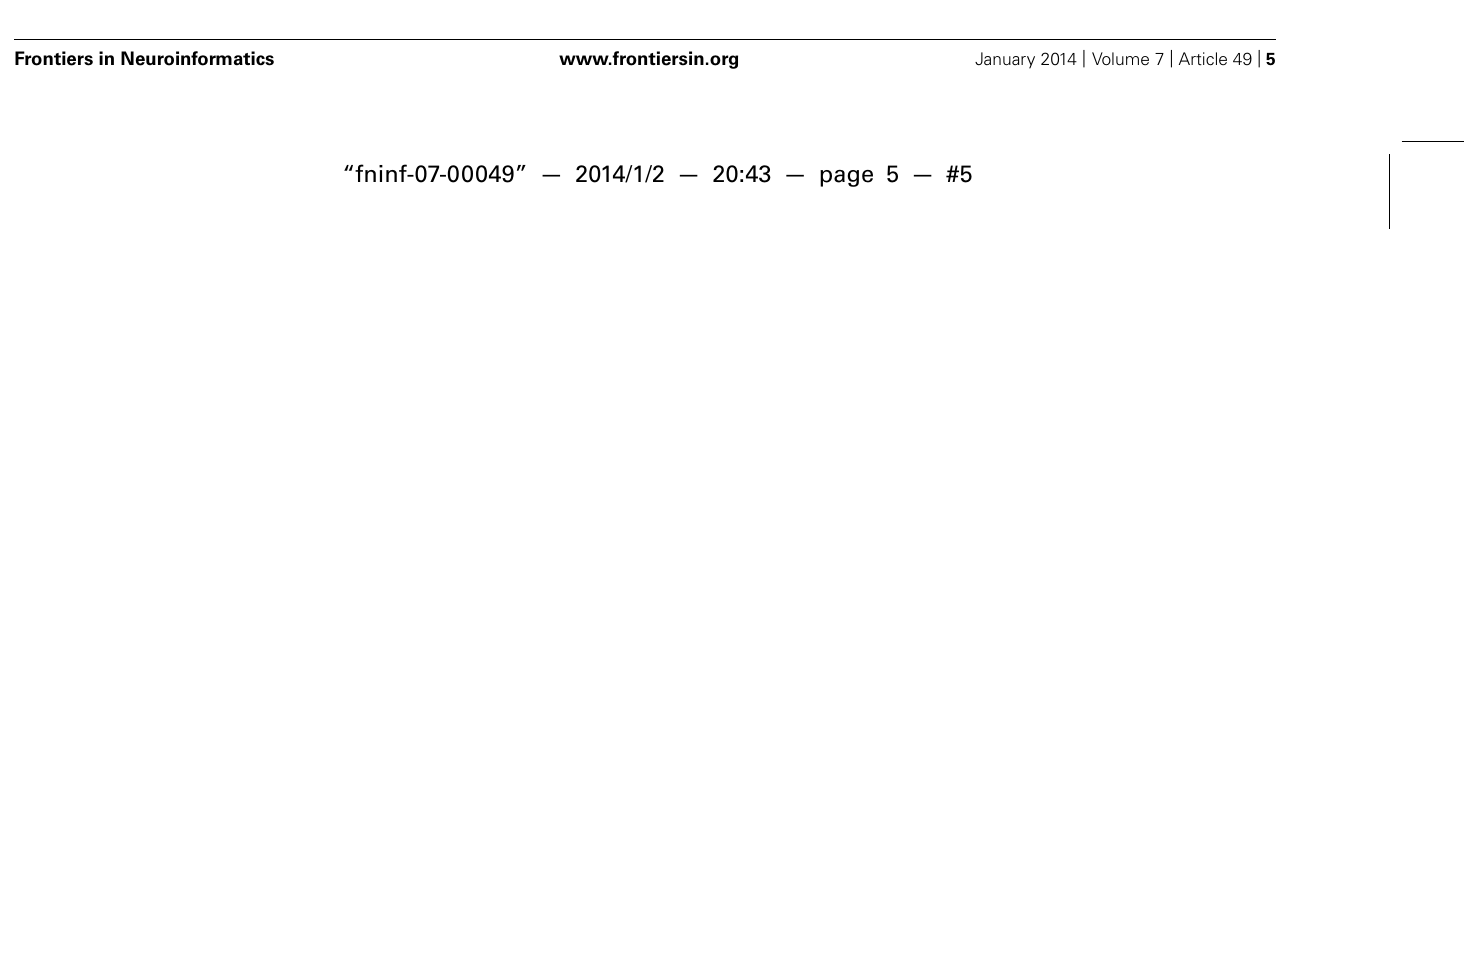
FIGURE 3 |TheHiveDB supports convention based import of tabular data. Scalar data can be imported on three levels: describing individuals (A) (e.g., gender, genetic data), individuals at timepoints (B) (e.g., clinical